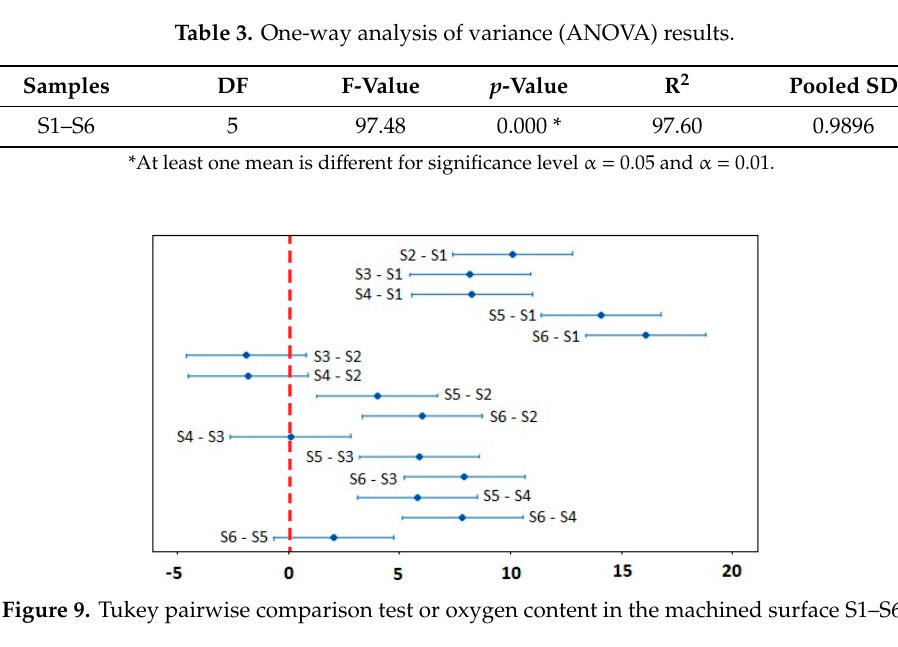
Figure 8. Weight percentage of oxygen content in the non-treated surface (N) and machined surfaces